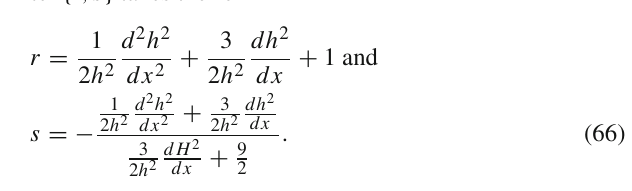
lie between the s